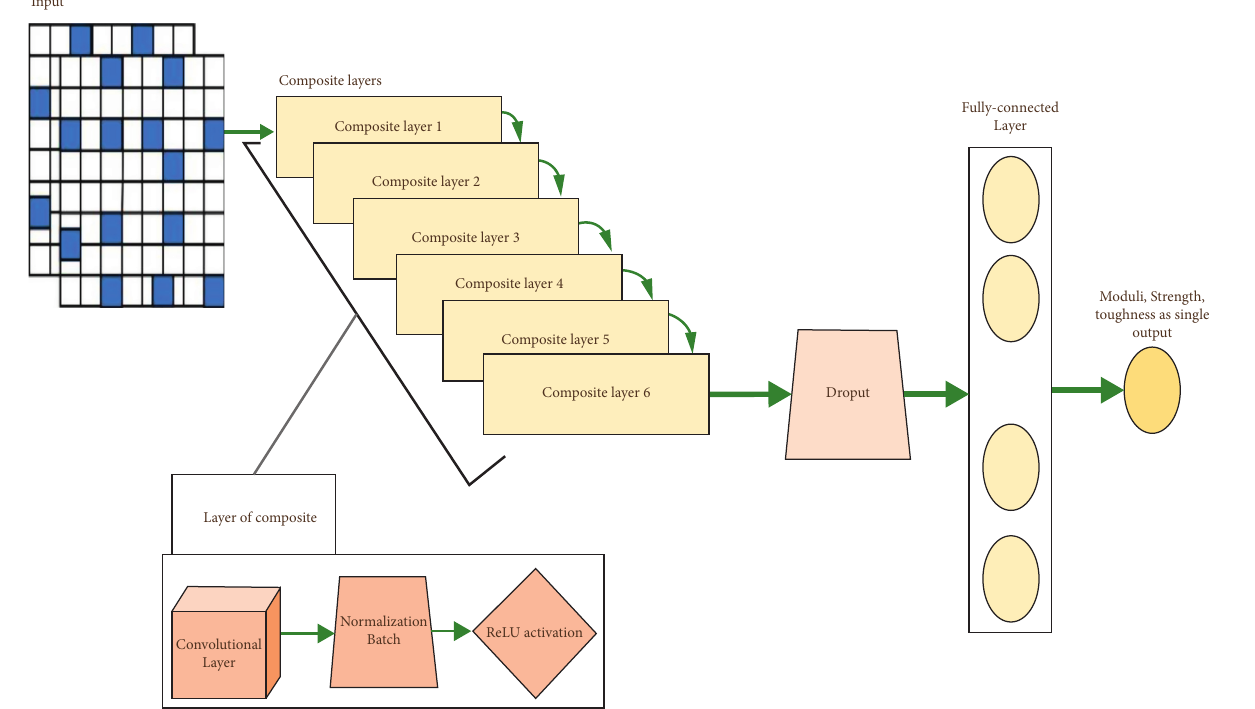
Figure 7: Schematic diagram of CNN